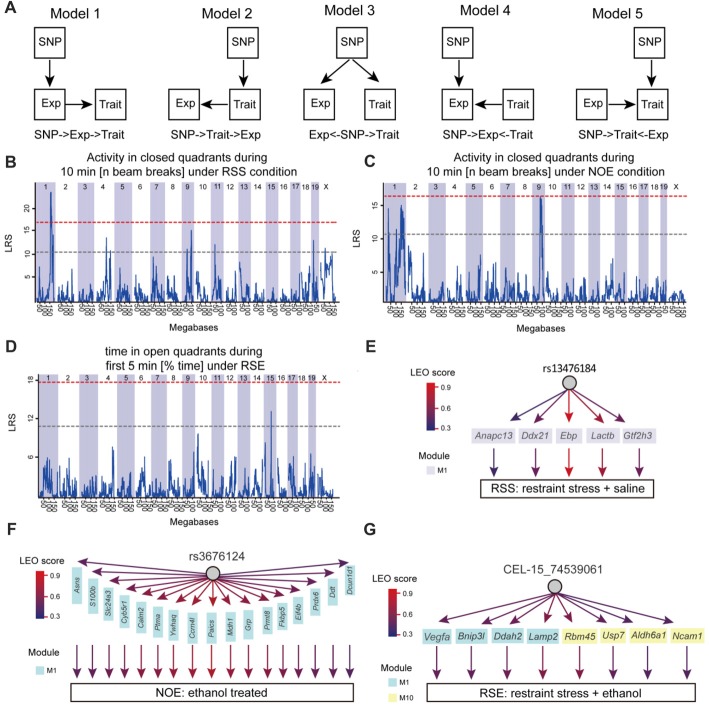
Causative analysis. (A) Schematic diagram showing SNP→Module→Phenotype causality analysis. Five possible Single Anchor Models were shown. (B–D) Quantitative trait locus (QTL) mapping for three conditions, including No restraint stress (NOS), RSS and RSE. (E–G) The causal network was constructed by SEM methods for NOE, RSS and RSE.